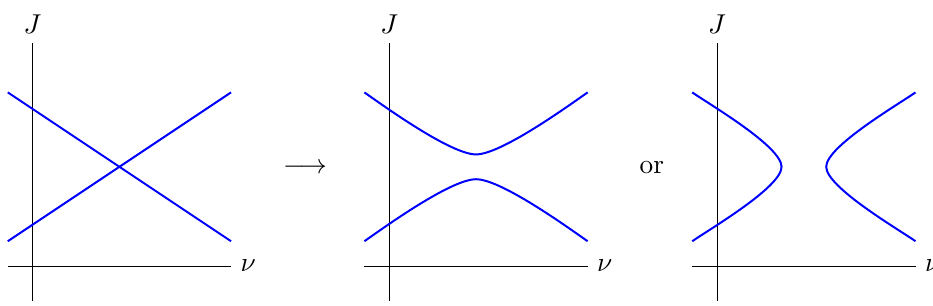
Figure 15. Left: naive level-crossing. Right: two generic resolutions for a non-Hermitian